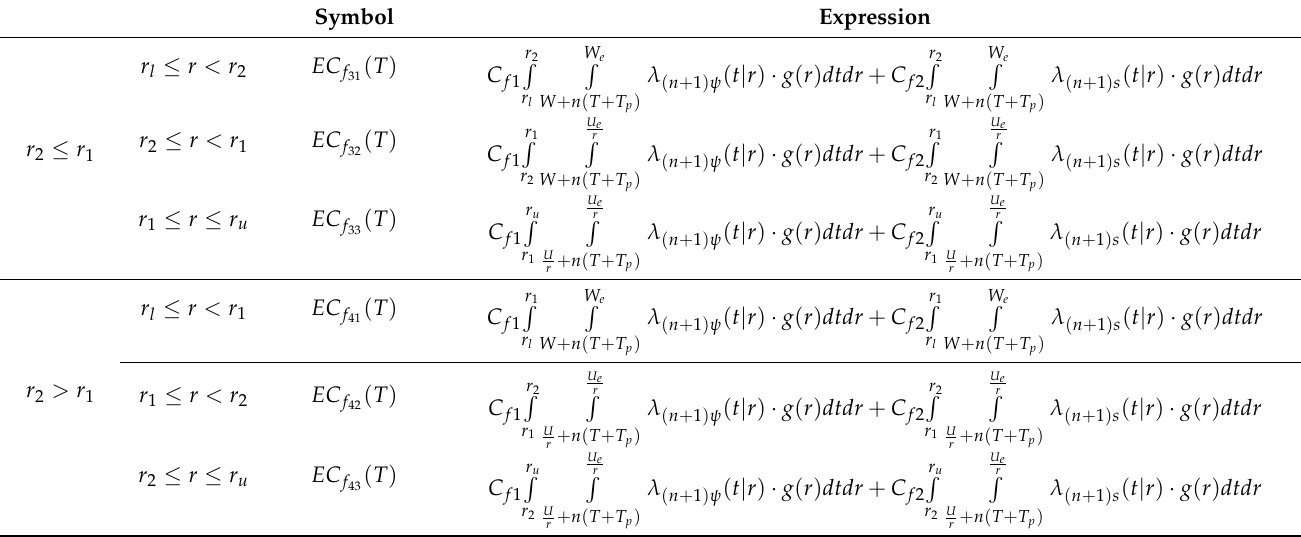
Table 1. The minimum total expected maintenance cost in [ W Θ ( r ) + n ( T + T p ) , W Φ ( r )]